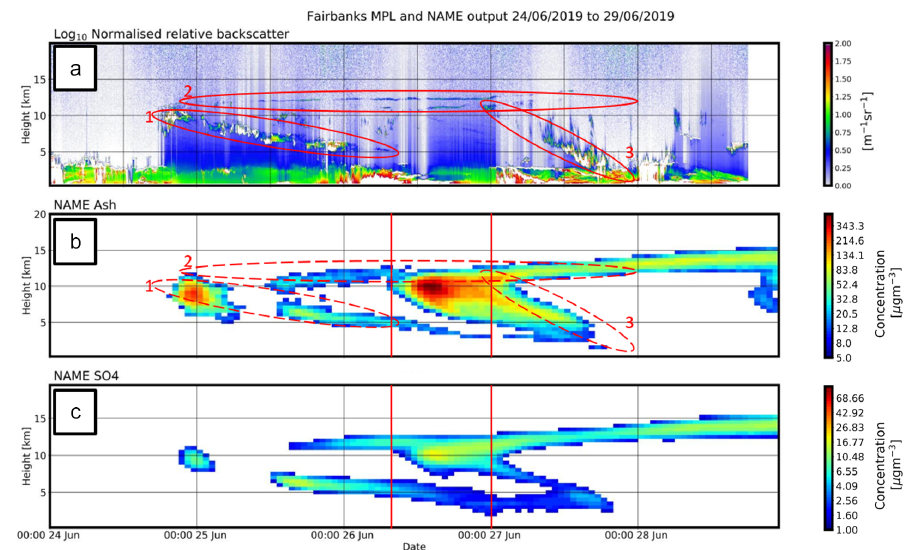
Figure 5. Fairbanks MPL lidar: (a) normalised relative backscatter [m − 1 sr − 1 ]; (b, c) NAME simulated air concentrations for ash and sulfate respectively [µgm − 3 ]. Data for 24 to 28 June 2019. The red outlines labelled 1, 2, and 3 and the vertical red lines are discussed in the